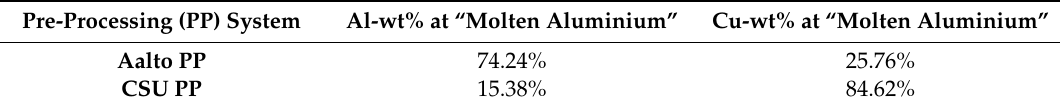
Table 3. Al recovery results.